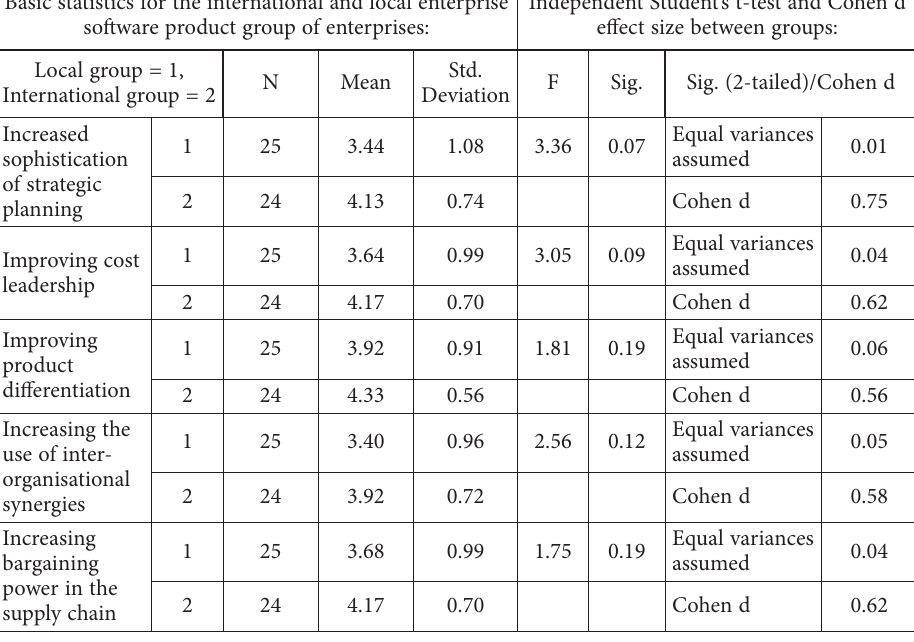
Table 3. The comparison of strategic characteristics between the enterprises that predominantly invest in pre-configured software products and those that predominantly invest in custom software products Basic statistics for the international and local enterprise Independent Student’s t-test and Cohen d software product group of enterprises: effect size between